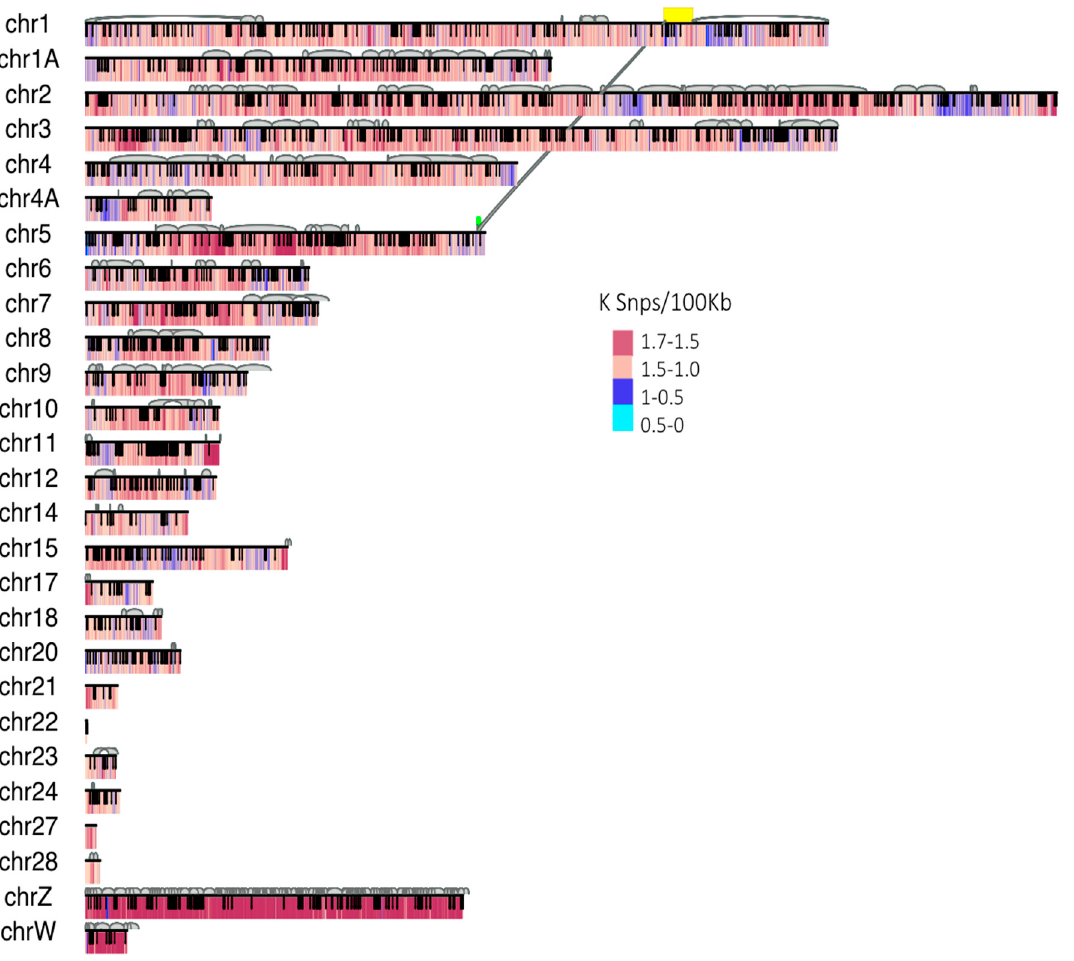
Figure 1. Chromosome ideogram. The black vertical lines represent UCE (Ultra Conserved Elements) placement in chromosome and the gray links represent large structural variants (insertions / deletions, inversions, duplications and rearrangements) over 30 Kb in size. The green rectangle represents two scaffolds that were homologous to Chr5 and Chr1 in multireference assembly, and the yellow rectangle represents scaffolds placed on Chr4 on single-reference assemblies.